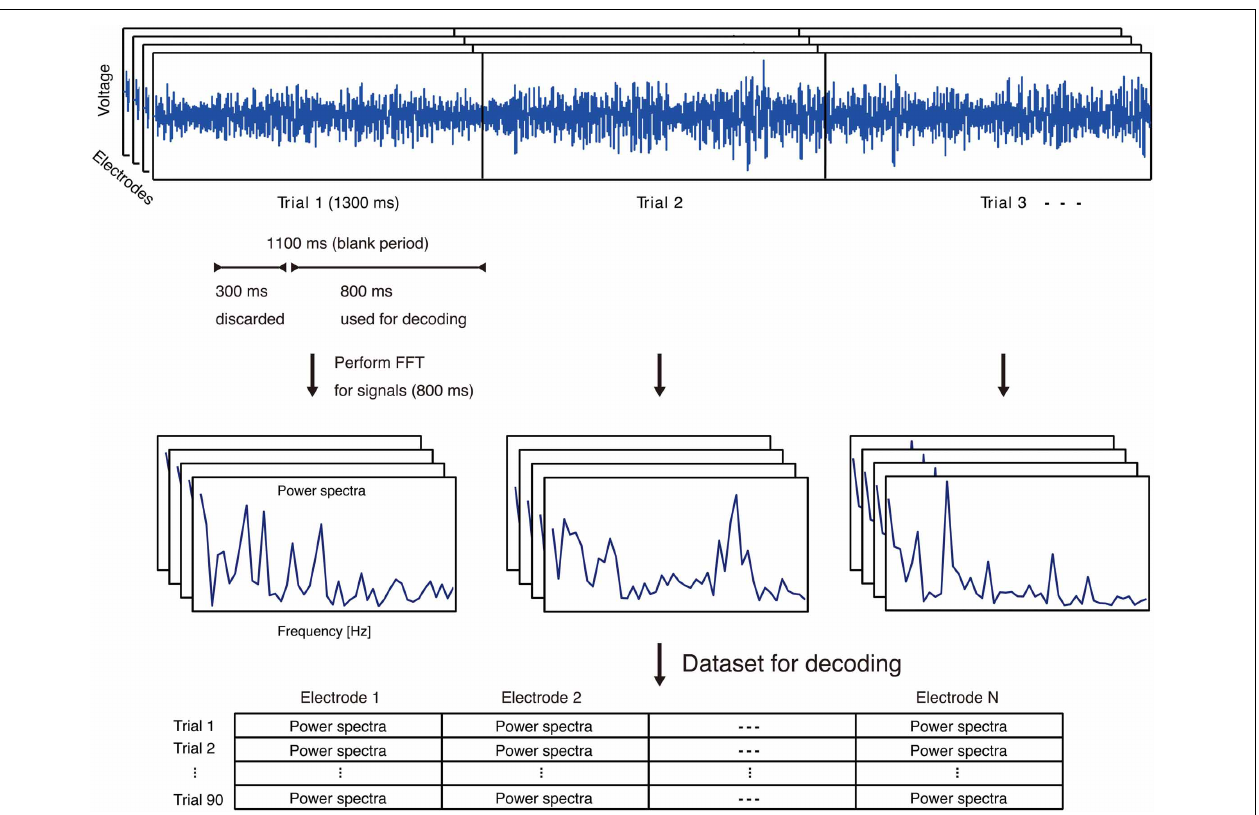
FIGURE 3 | Feature extraction process using ECoG signals. Top: Representative ECoG signals recorded in individual trials. The ECoG signals recorded in an early stage of individual trials could reflect immediate responses to visual stimuli. In order to decode single vowels based on information from covert articulation, and not